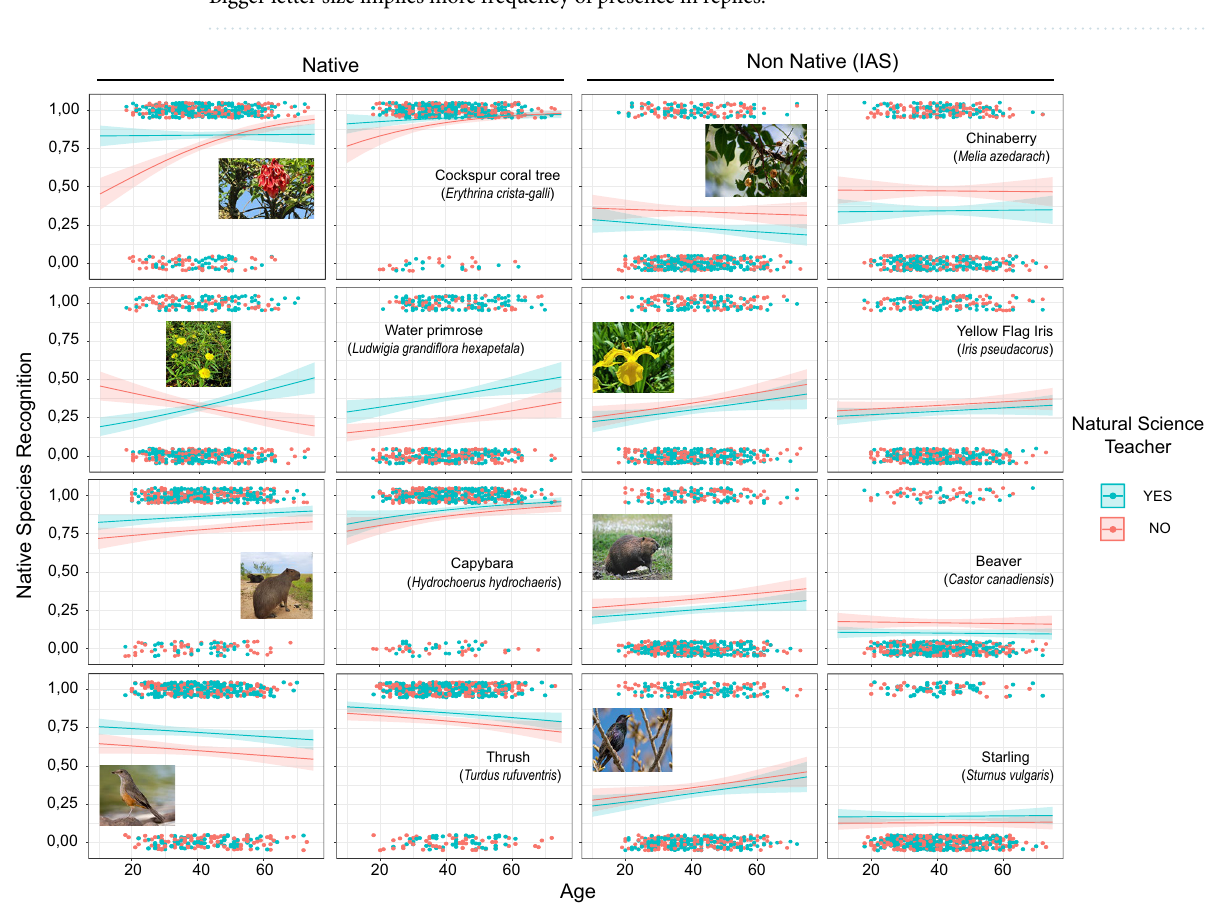
Figure 4. Predicted models of native and non-native species (invasive alien species, IAS) recognition from their photos and written names, considering age as an explanatory continuous variable in X axis and Natural Science Teachers (NST) of the respondents as categorical explanatory variable in two colours. Native species are shown on the left of the figure and non-native species on the right. Each frame consists of the respondent’s recognition of native species offered graphed as dots (1 = native and 0 = non-native). Curves and confidence bands (95%) came from generalised linear